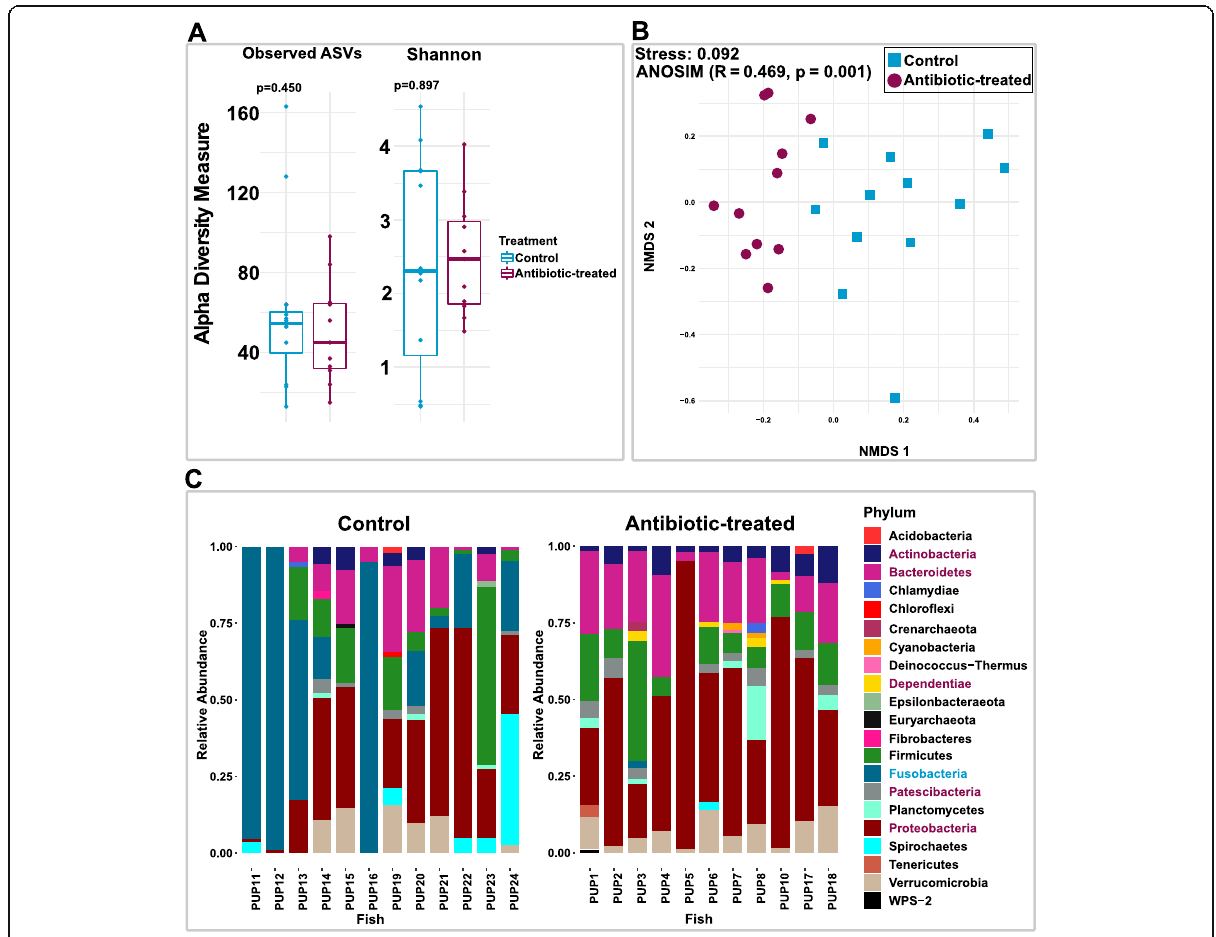
Fig. 2 Microbial diversity analysis. a Box-and-whisker plots of alpha diversity metrics (Observed ASVs and Shannon index). Each box represents interquartile range; the line inside the box is a median. b Bray – Curtis dissimilarity-based non-metric multidimensional scaling (NMDS) plot showing the distribution of antibiotic-treated and control fish samples in ordination space. c ) Bar plot showing the relative abundance (> 1%) of gut microbiota at the phylum level. Five phyla indicated in cherry-red color in legend were significantly higher (Welch ’ s t-test, p < 0.05) in antibiotic-treated fish, whereas the one indicated in cyan ( Fusobacteria ) was significantly depleted (Welch ’ s t-test, p < 0.05). The